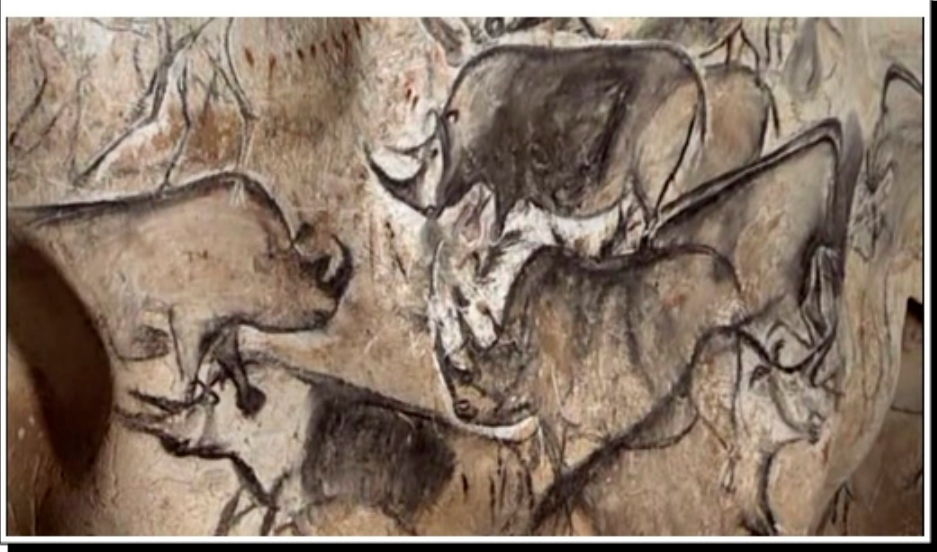
Figure 11. Rhinoceros drawings from Chauvet Cave (30,000 BCE).